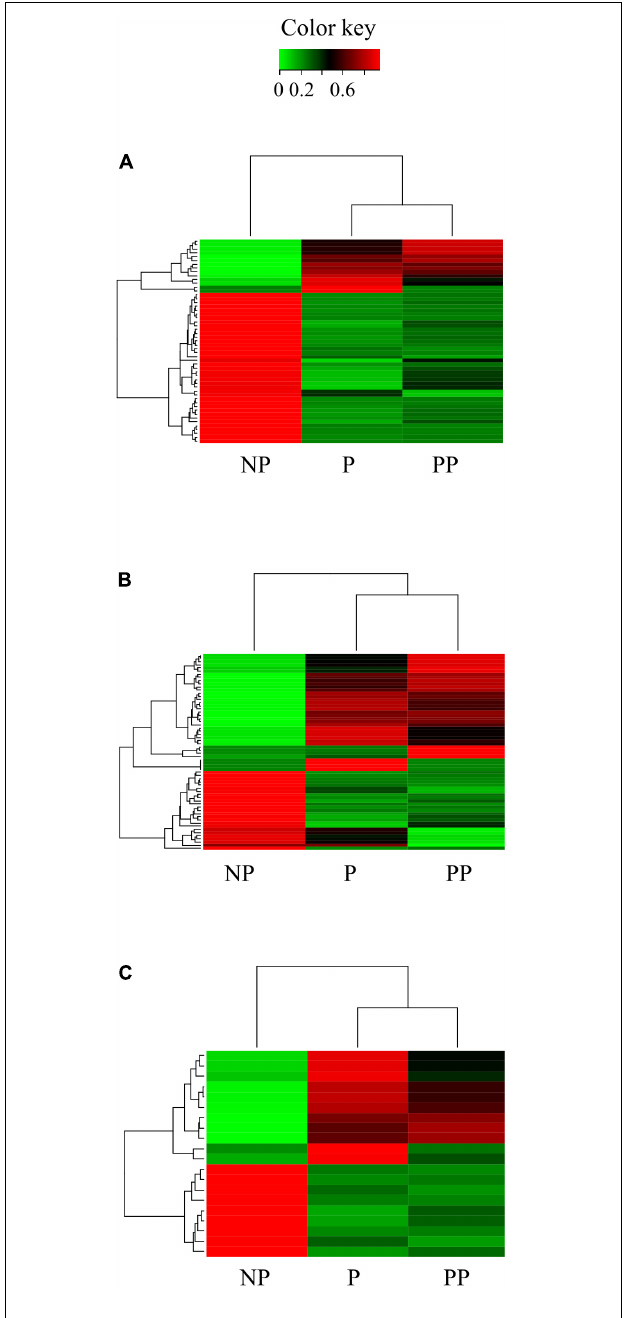
FIGURE 5 | Heatmap of sequences of (A) ribosomal proteins, (B) transcription factors, and (C) translation factors regulated in larvae Diatraea saccharalis parasitized and pseudoparasitized by Cotesia